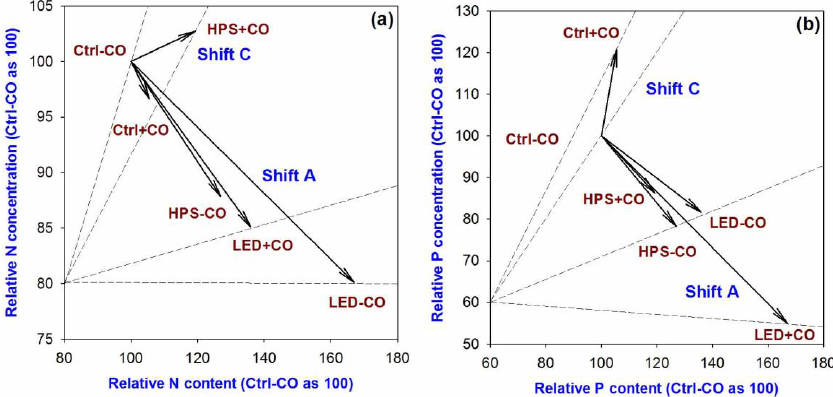
Figure 6. Vector analysis of biomass, nutrient content, and concentration for N ( a ) and P ( b ) in leaves of Fragrant rosewood ( D odorifera ) seedlings cultured in the interactive effects of chitosan oligosaccharide addition and lighting spectra. Ctrl, the control of the natural illumination; HPS, high-pressure sodium; LED, light-emitting diodes; − CO, the treatment without chitosan oligosaccharide addition; +CO, the treatment with chitosan oligosaccharide addition. Shift A indicates the symptom of relative nutrient dilution in the object; shift C indicates the symptom of the relative nutrient deficiency in the reference.